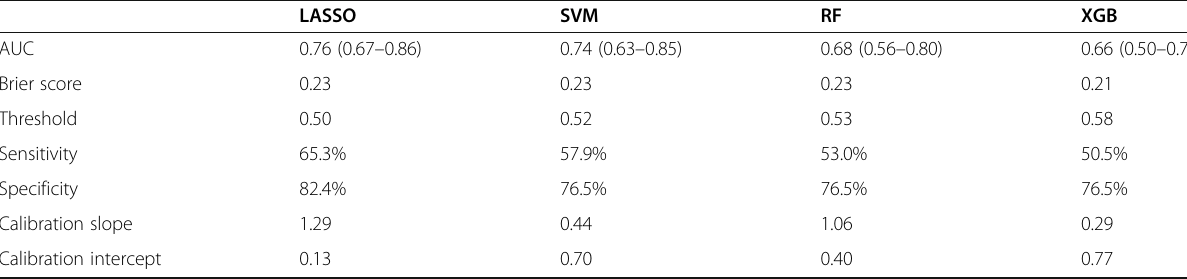
Table 3 Model performance for predicting patient satisfaction on test set ( n =